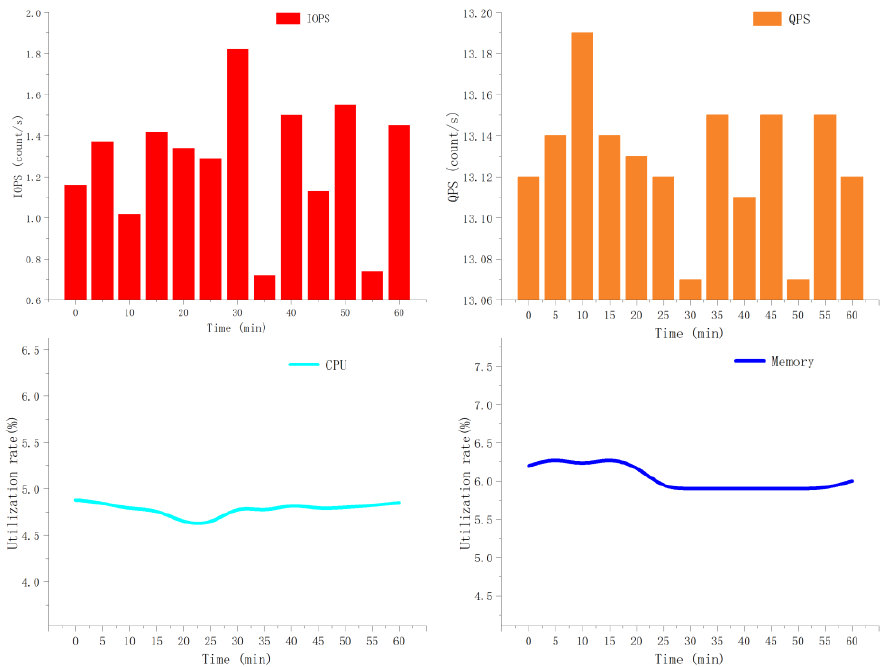
Figure 15. Cloud database performance parameters within one hour. IOPS means input and output operations per second, QPS means queries per second, and CPU means central processing